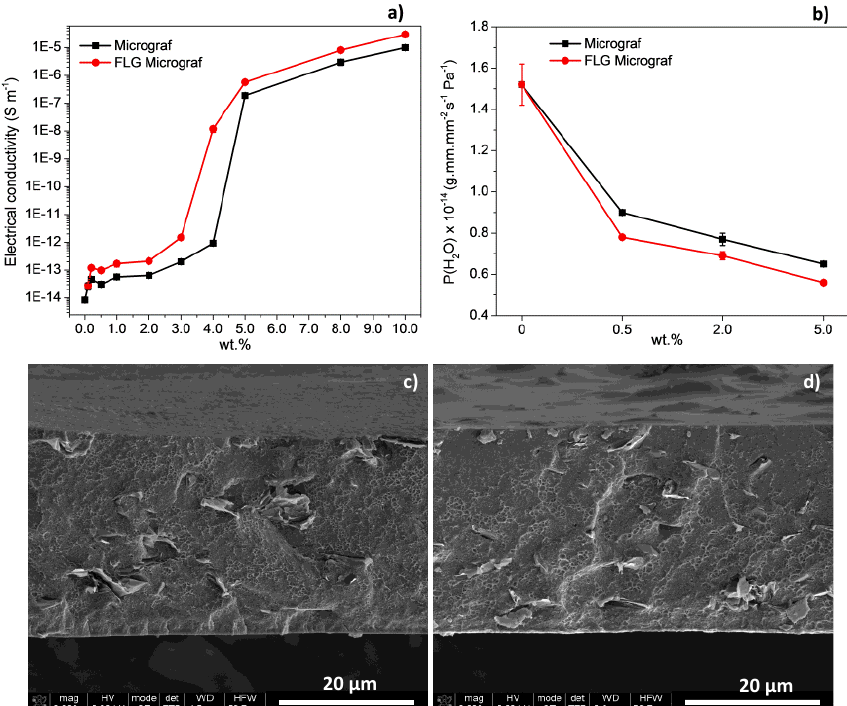
Figure 9. ( a ) Electrical conductivity; ( b ) coefficient of moisture permeability; and SEM images for the Figure 9. (a) Electrical conductivity; (b) coefficient of moisture permeability; and SEM images for the Micrograf ( c ) and FLG Micrograf WPU ( d ) composite films at different Micrograf ( c ) and FLG Micrograf WPU ( d ) composite films at different loadings.